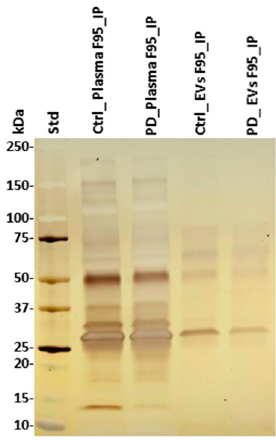
Figure 4. F95-enriched fractions from plasma and plasma-EVs from pre-motor PD model and sham rats. Silver stained sodium dodecyl sulfate polyacrylamide gel electrophoresis (SDS-PAGE) gel (4–20% gradient gel), showing F95-enriched protein bands from whole plasma and plasma-EVs in pre-motor PD and sham (control) rats. The protein standard is indicated on the far left in kilodaltons (kDa) (ctrl = sham; PD = pre-motor PD models).